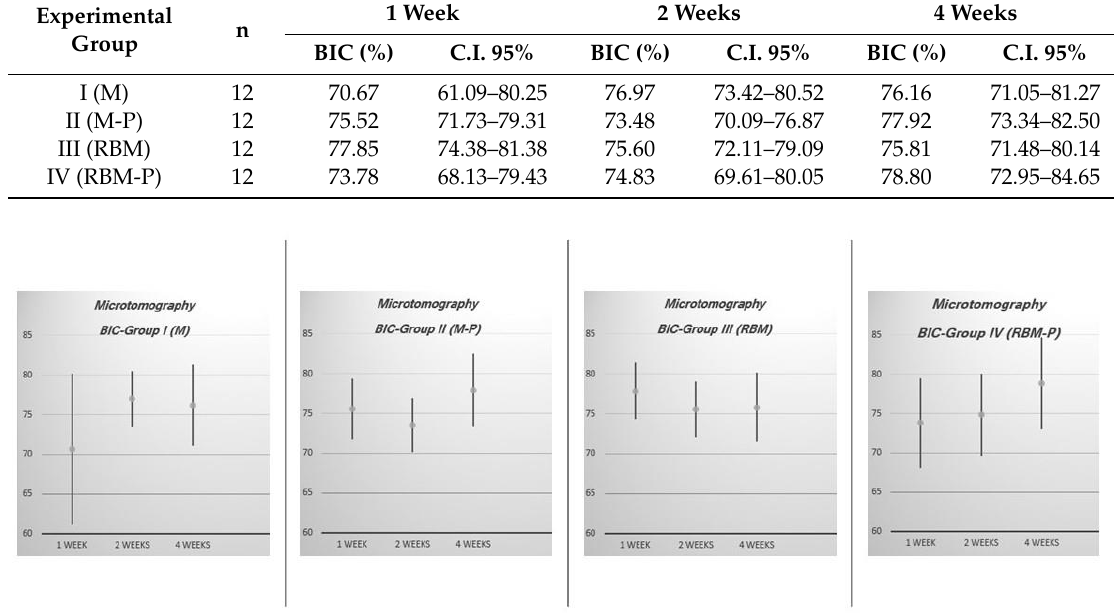
Figure 2. BIC percentages with the C.I. (95%) of each experimental group obtained by microtomography Graphic 1. BIC percentages with the C.I. (95%) of each experimental group obtained by at 1, 2 and 4 microtomography at 1, 2 and 4 weeks.